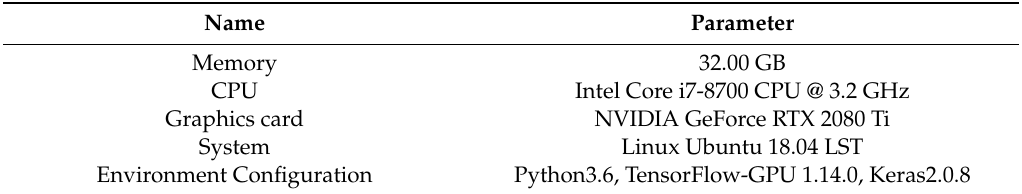
Table 3. Hardware and software parameters of the experimental